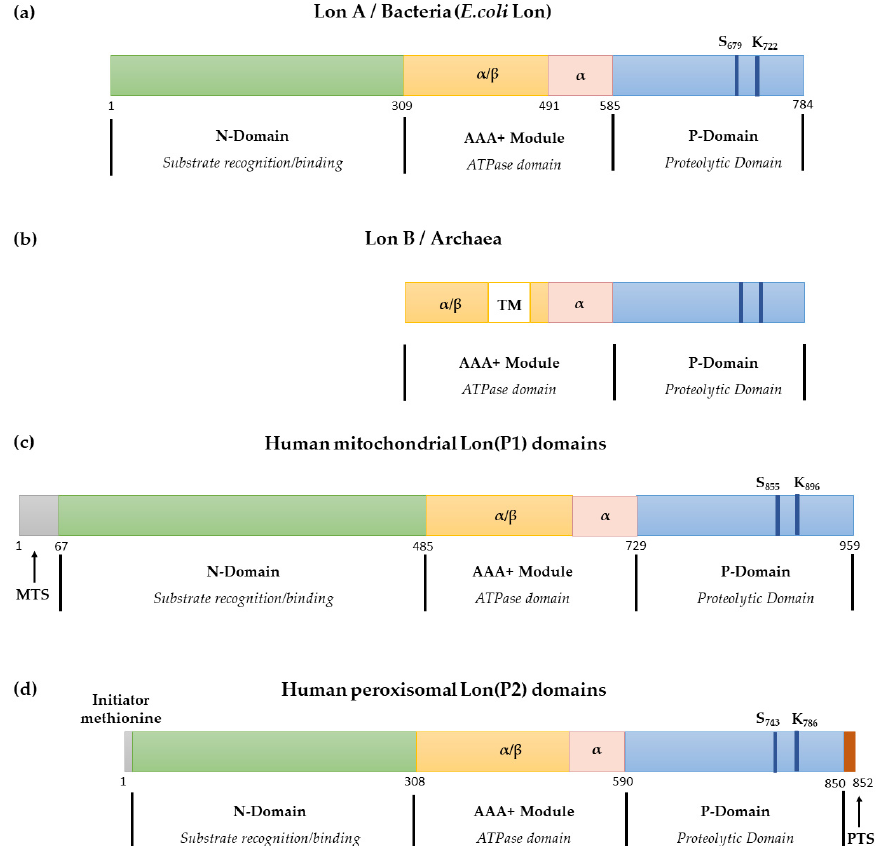
Figure 1. ( a ) Structure of Lon A in the primary amino acid sequence, exampled by the E. coli Lon. ( b ) Structure of Lon B in the primary amino acid sequence. TM, transmembrane region. ( c ) Structure of human mitochondrial Lon (P1) in the primary amino acid sequence; MTS, mitochondrial targeting sequence. ( d ) Structure of human peroxisomal Lon(P2) in the primary amino acid sequence; PTS, peroxisomal targeting sequence.